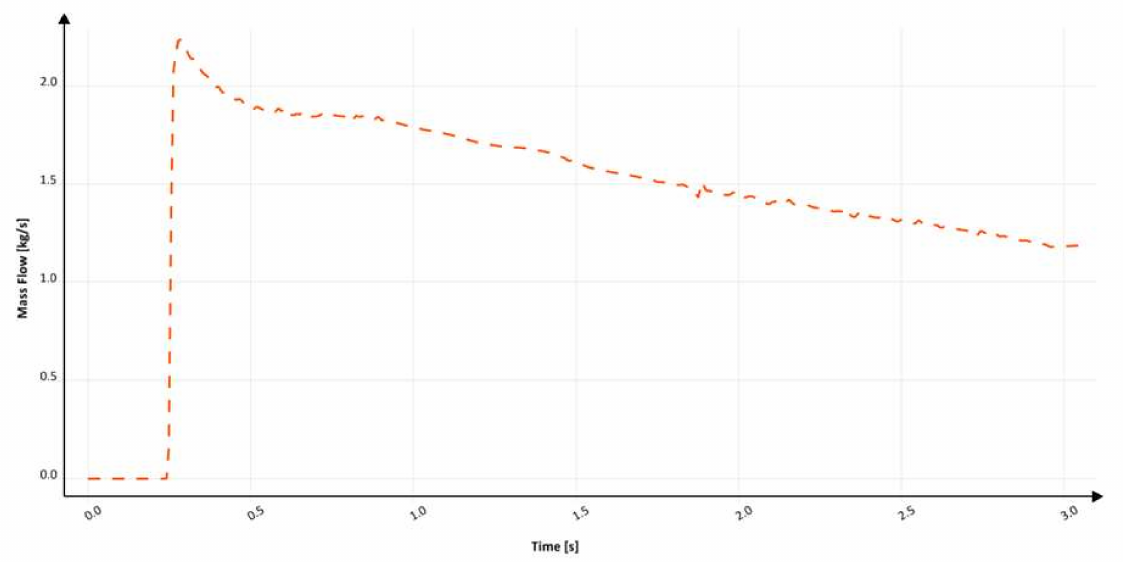
Figure 35. Mass flow through an ingate with thin rectangular sprue with hyperbolic taper (S s 9), MAGMASOFT.